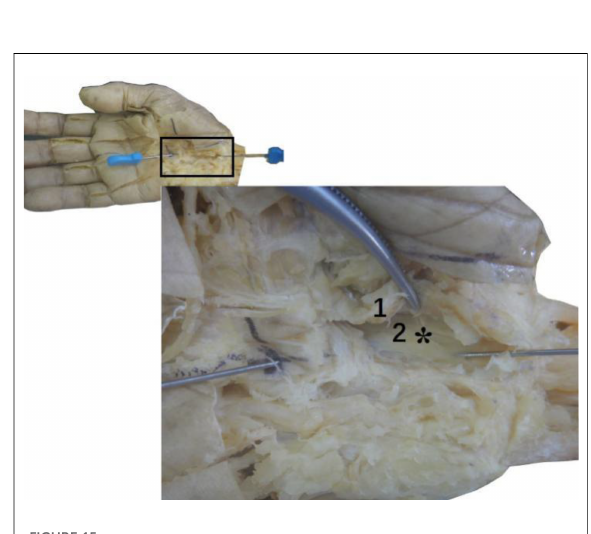
FIGURE 15 The median nerve was scratched by a needle knife in the non- ultrasound guided group. The asterisk refers to the cutting marks of the needle knife. 1, Transverse carpal ligament (turned up in section); 2, Median